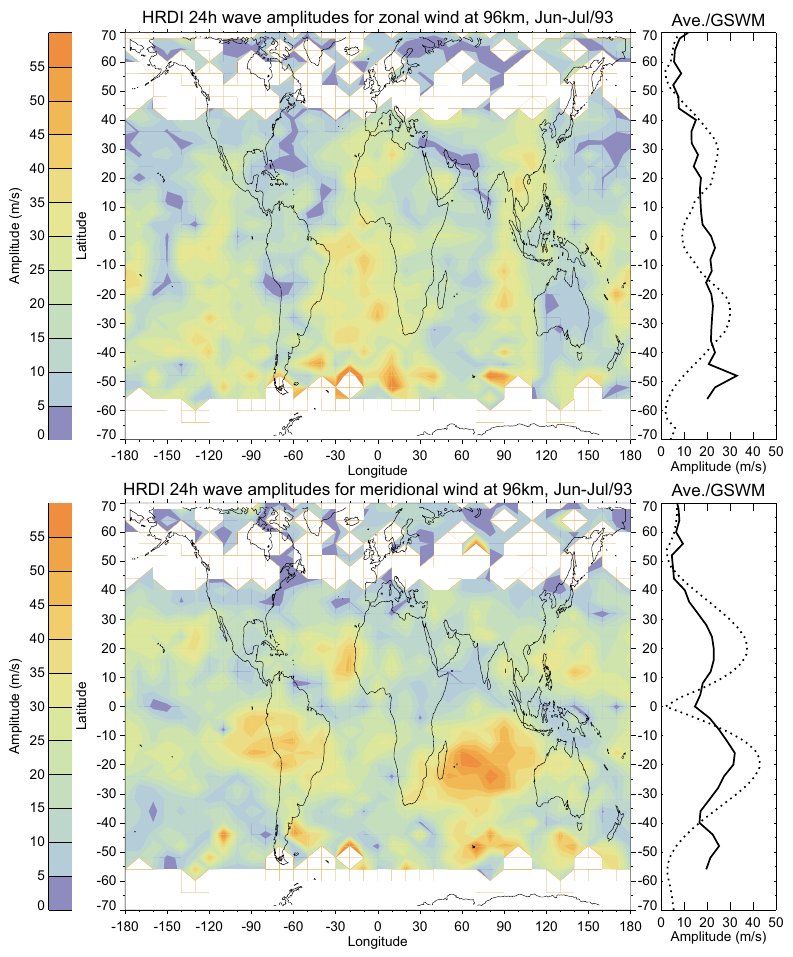
Fig. 1. Contoured plots of 24-h tidal amplitudes for June–July 1993 from HRDI. The longitudinal averages are to the right (solid line), and also the GSWM-2000 values